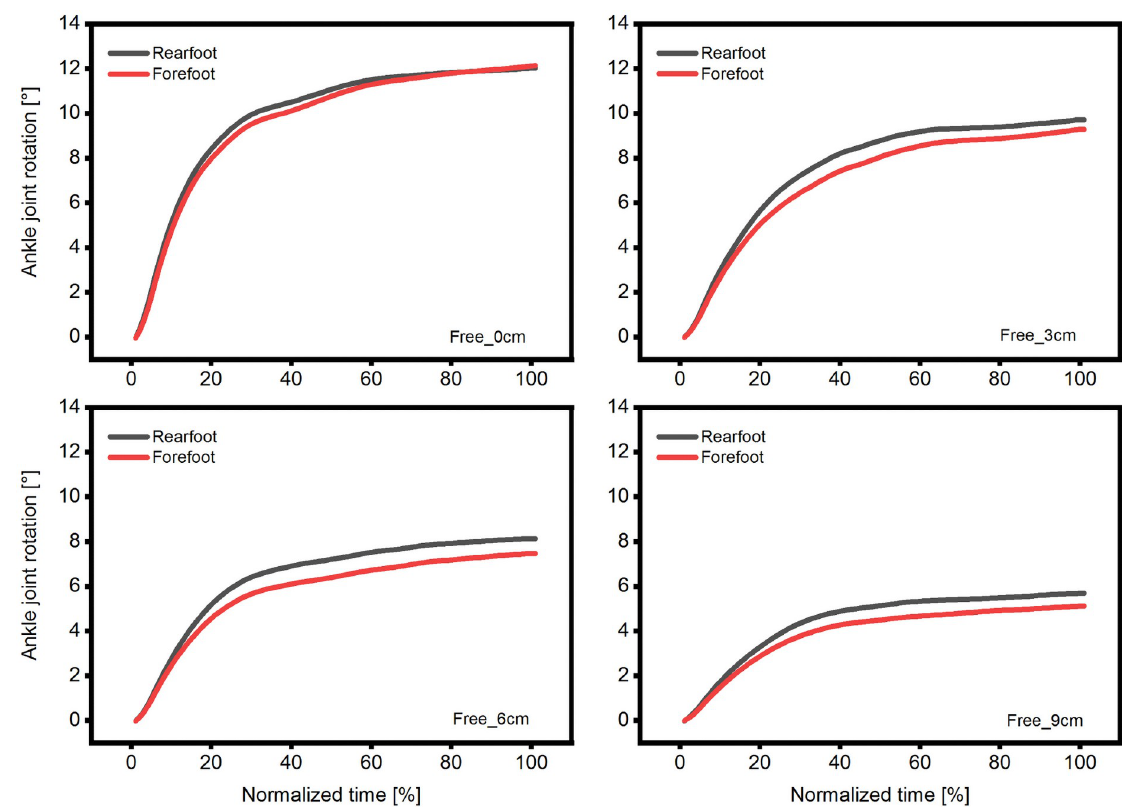
Fig 5. Time normalized ankle joint rotation at four different positions in free condition. Time normalized average ankle joint angle measured in rearfoot and forefoot measuring sites at four different positions (0–9 cm) and in free condition. For clarity, the standard deviation is not presented (n =